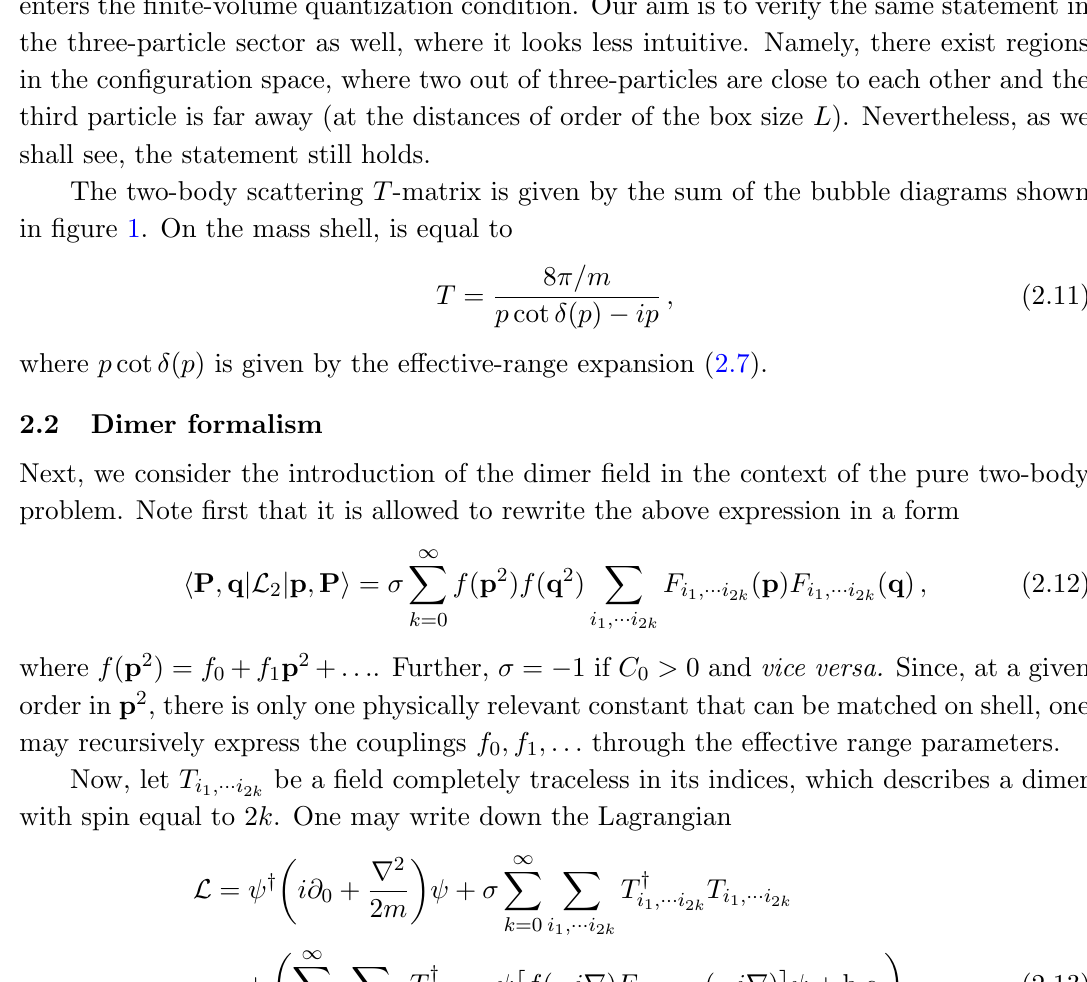
+ + + ... Figure 1 . T -matrix in the non-relativistic theory. The (cid:12)lled boxes represent the tree-level La- grangian containing the low-energy couplings C 0 ; C 2 ; C 4 ; : : :